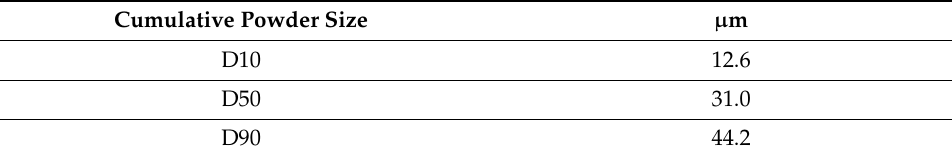
Table 2. Cumulative powder size of